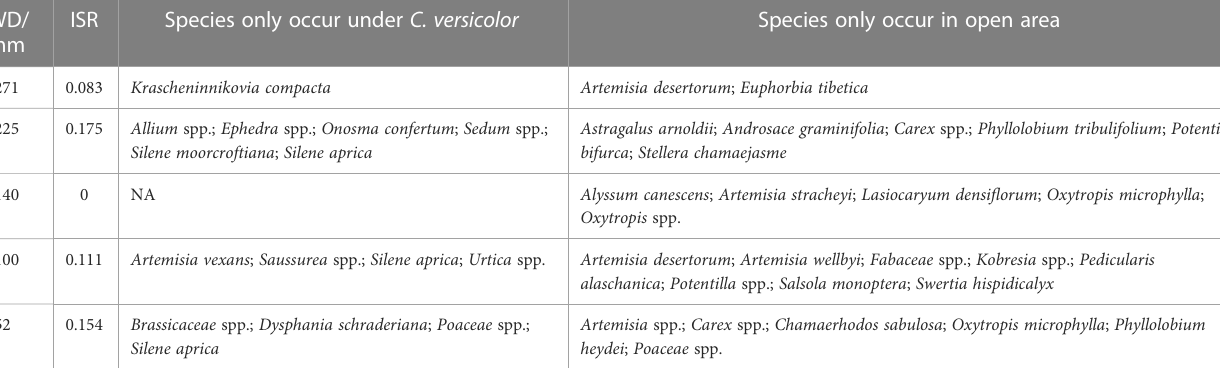
TABLE 1 Water de fi cit (WD), the proportion of increase in herbaceous species richness (ISR) and species occurrence under Caragana versicolor or in open areas across 5 sampling sites in drylands of Tibetan Plateau. WD/ ISR Species only occur under C. versicolor mm